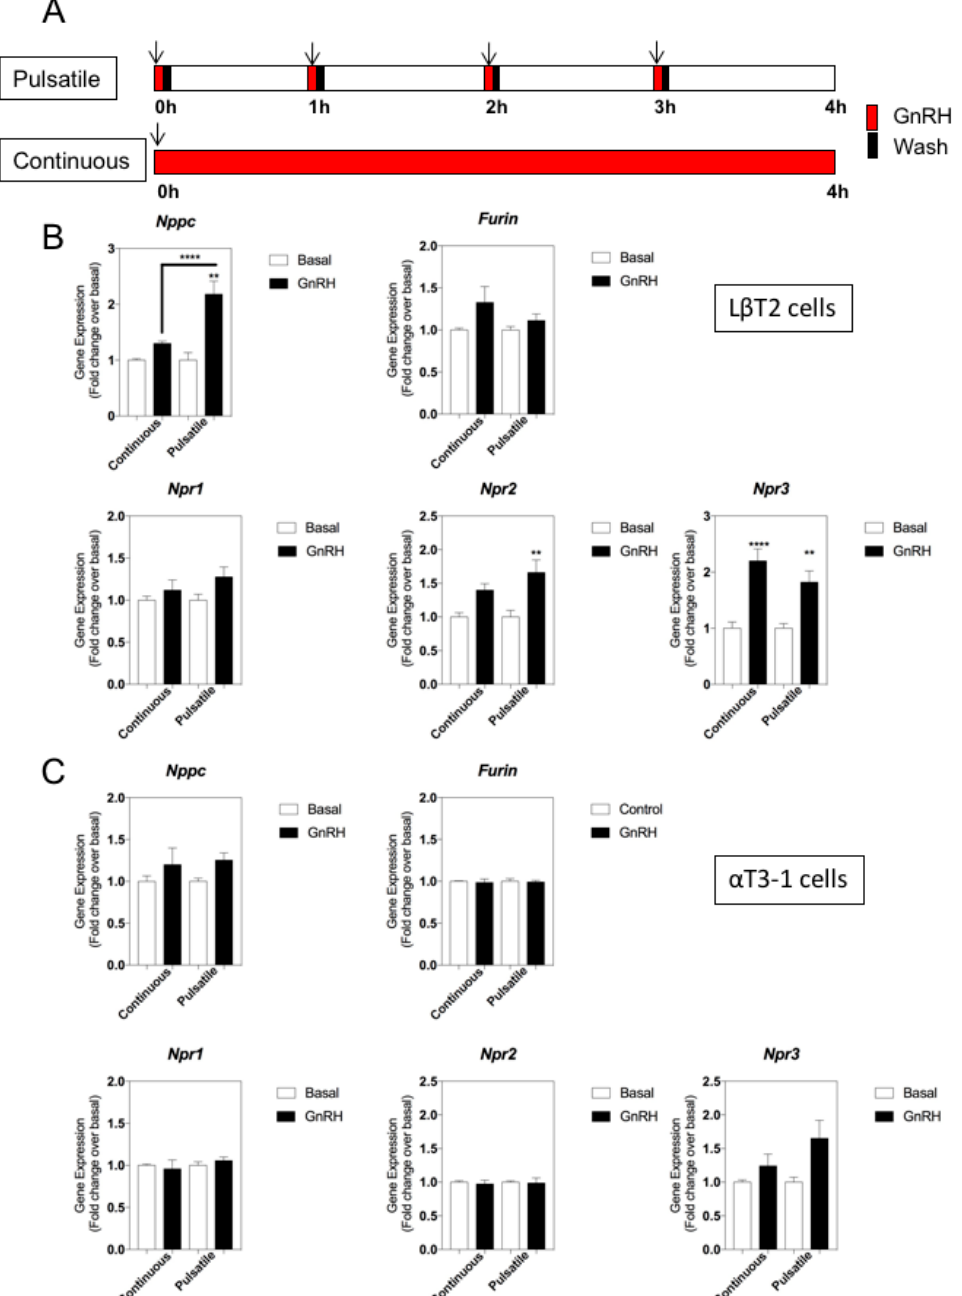
Figure 3. E ff ect of continuous or pulsatile GnRH stimulation on natriuretic peptide gene expression in L β T2 and α T3-1 cell lines. ( A ) Schematic of pulsatile or continuous GnRH treatment protocol, including wash periods. L β T2 cells ( B ) or α T3-1 cells ( C ) were treated with 0 or 100 nM GnRH, for either 4 h continuously, or as 5 min pulses every hour for 4 h, before extracting RNA and performing multiplex RT-qPCR to examine alterations in gene expression profiling of natriuretic peptide system ( Nppc , Furin , Corin , Npr1 , Npr2 , Npr3 ). Data shown are means ± SEM (n = 6 to 9 individual RNA extractions) of relative gene expression (normalized to ActB ); *** p < 0.001, ** p < 0.01, significantly di ff erent from basal, or continuous vs pulsatile, as indicated).